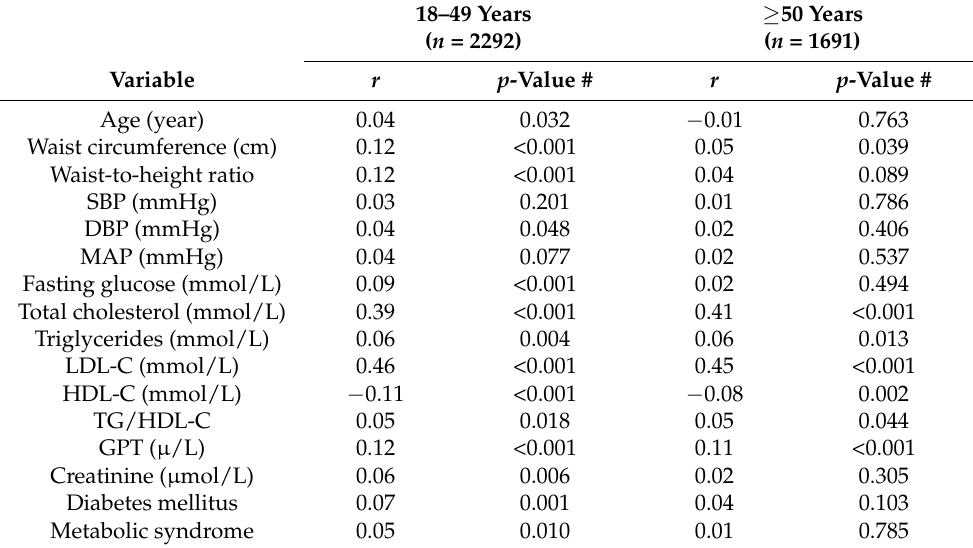
Table 2. Pearson’s correlation coefficients between Lp-PLA2 levels and clinical/metabolic character- istics in men by